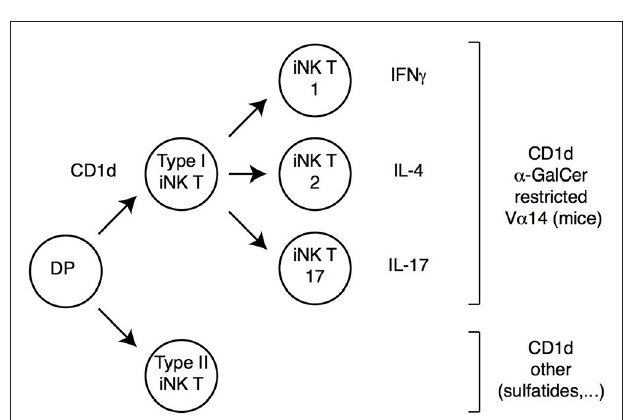
FIGURE 2 | iNK T cell subsets. DP thymocytes signaled by CD1d-bound lipids differentiate into iNK T cells. Most iNK T cells (Type I iNK T cells) express a V α 14 invariant TCR α chain (and exhibit a reduced TCR β chain diversity), and recognize CD1d-bound α -Galactosyl-Ceramide ( α GalCer). These cells undergo functional differentiation in the thymus (requiring the transcription factor PLZF) into IFN γ , IL-4 or IL-17-expressing effector fates (therefore referred to as iNK T1, T2, or T17, respectively). A smaller subset of CD1d-signaled cells (Type II iNK T cells) does not carry the prototypical V α 14 chain and does not recognize α GalCer; these cells also undergo functional differentiation, although specific cytokine expression patterns are not as extensively characterized as for Type I iNK T